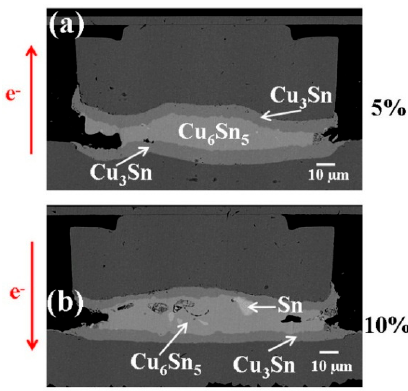
Figure 2. Cross-sectional SEM images of solder bumps with Cu column UBM stressed at 1.45 × 10 4 A/cm 2 at 185 °C with bump resistance increases ( a ) 5% with upward electron flow and ( b ) 10% with downward electron flow.